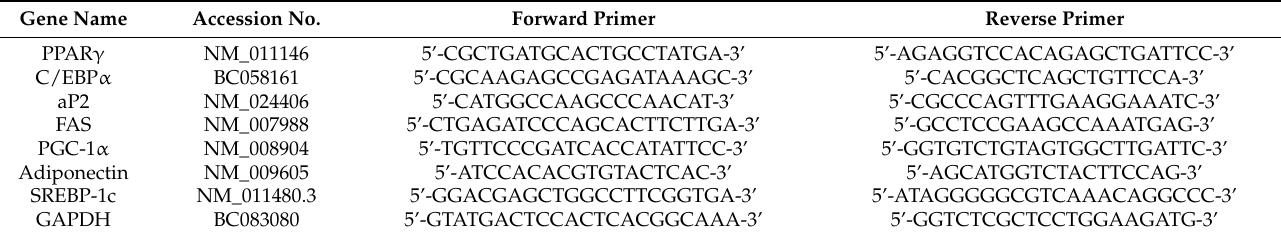
Table 1. Primer sequences used for real-time